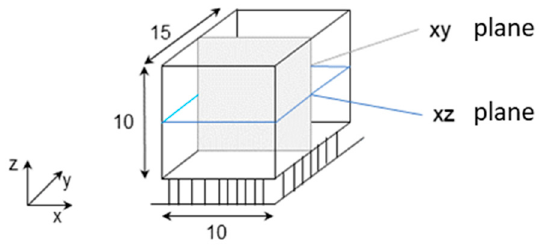
Figure 3. Definition of microsectioning planes.